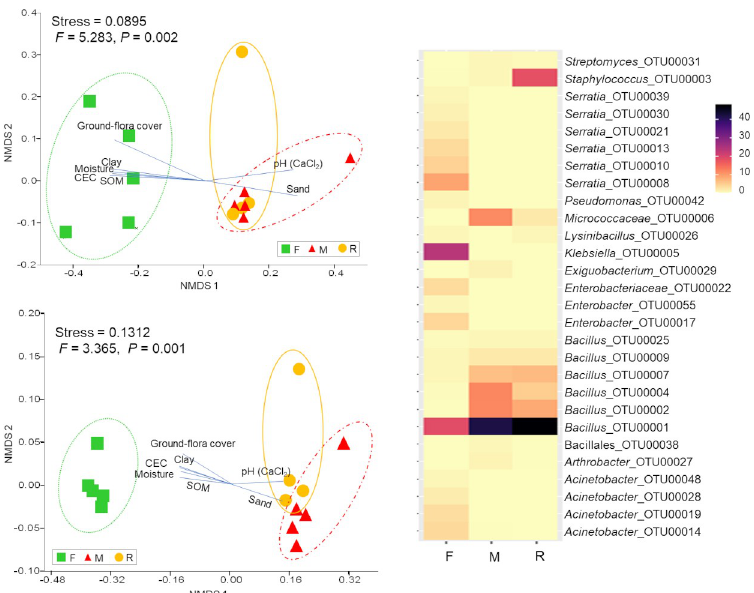
Fig 3. Bacterial community composition. Non-metric multidimensional scaling (NMDS) ordination of bacterial communities, under three different treatments (square: forest (F), triangle: mine (M) and circle: young mine- rehabilitation (R), based on Bray-Curtis distance (top left) and Jaccard distance (lower left). Significant representative soil physico-chemical properties and plant variables ( P < 0.05) were plotted in the respective NMDS ordination plots. Heat-map showing the percentage of OTU relative abundance (over 0.05% of the community in each sample).